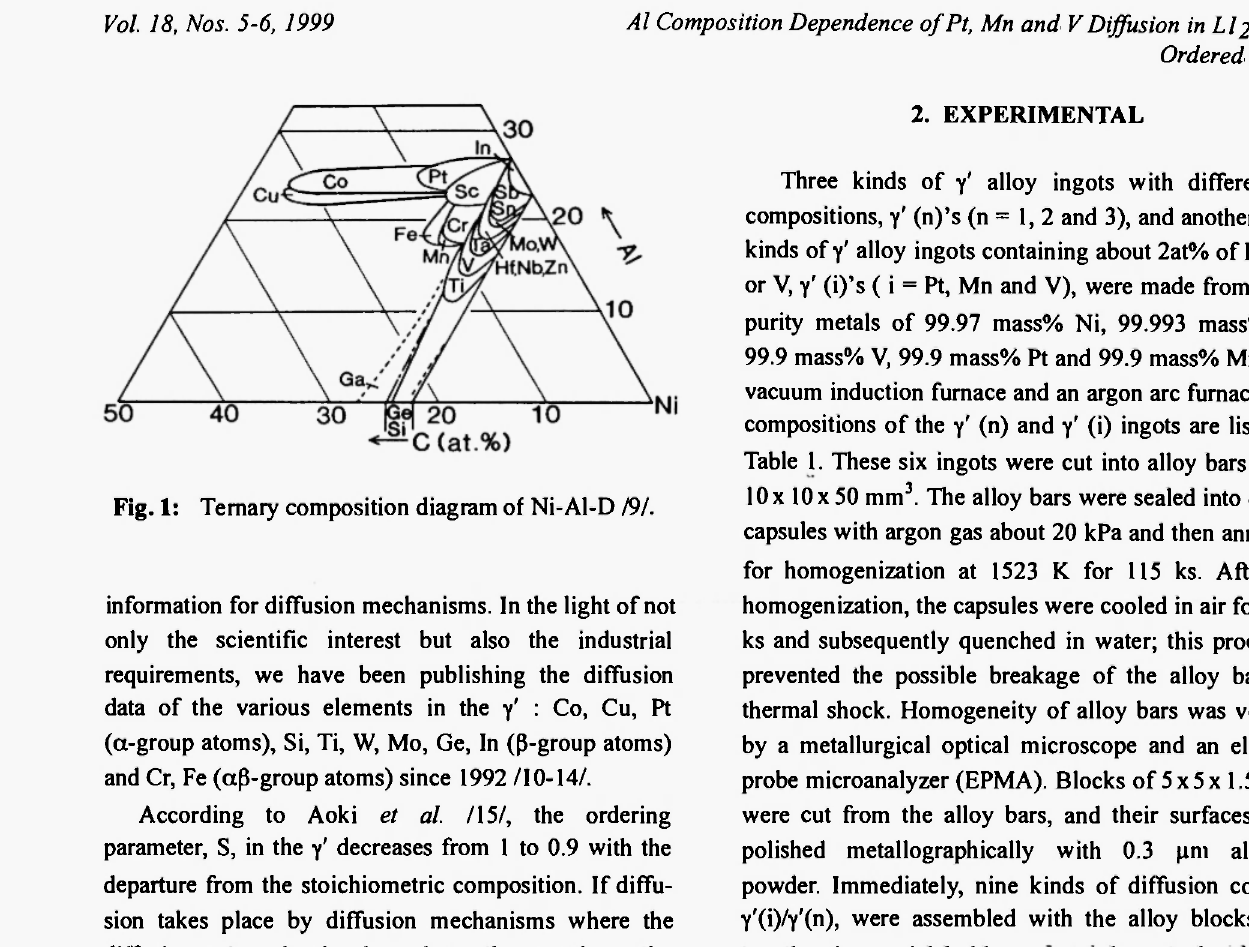
The terminal compositions of the diffusion